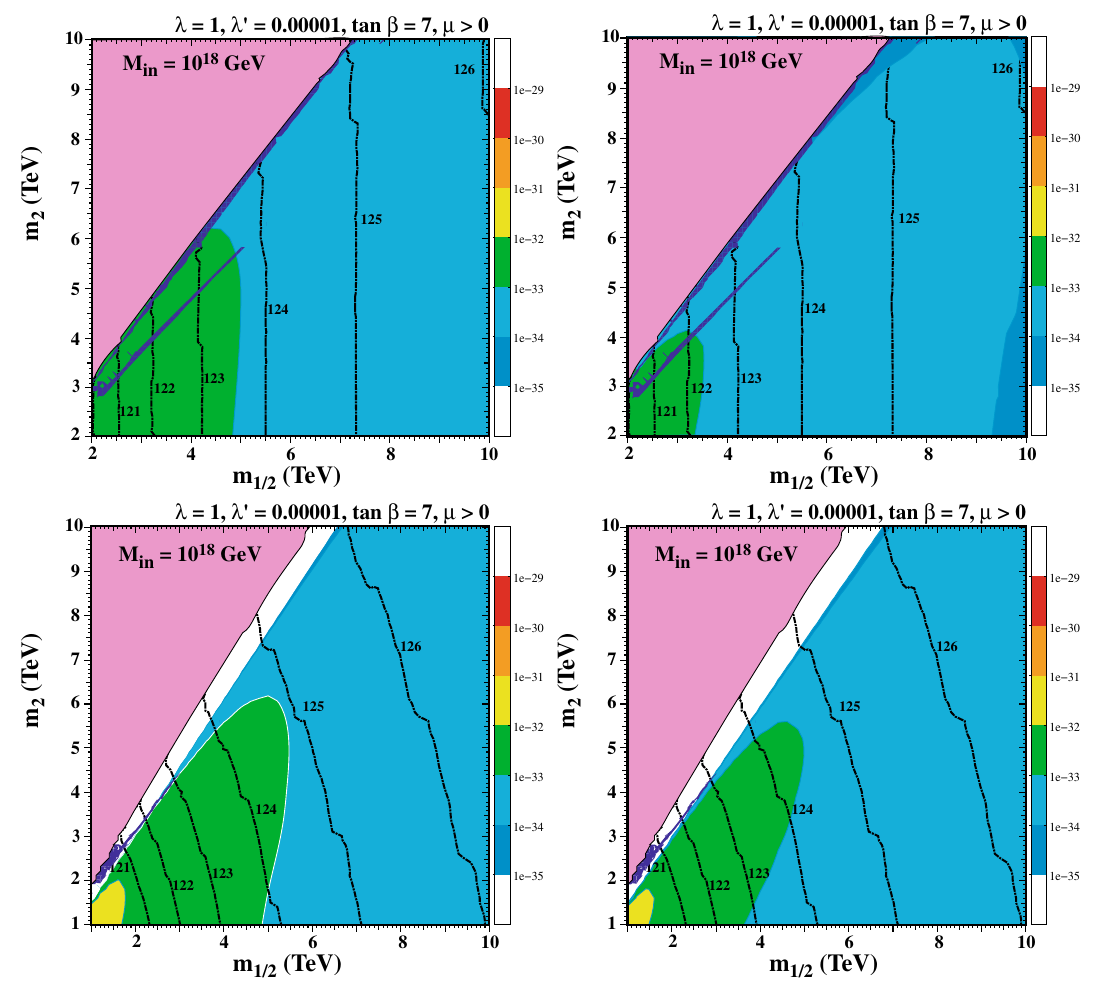
tan β = 7, λ (cid:8) = 0 . 00001 and λ = 1. The color-coding for the electron EDM is indicated in the bars beside the